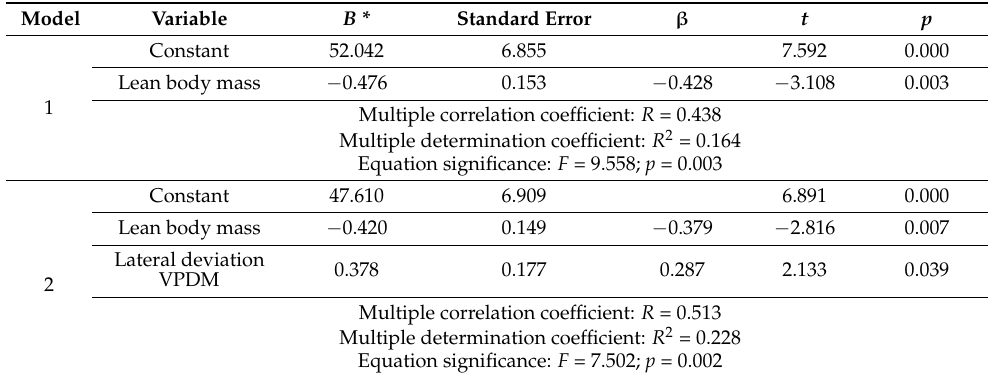
* Refers to the unstandardized coefficient. β —standardized regression coefficient. t —significance level of β . F—equation